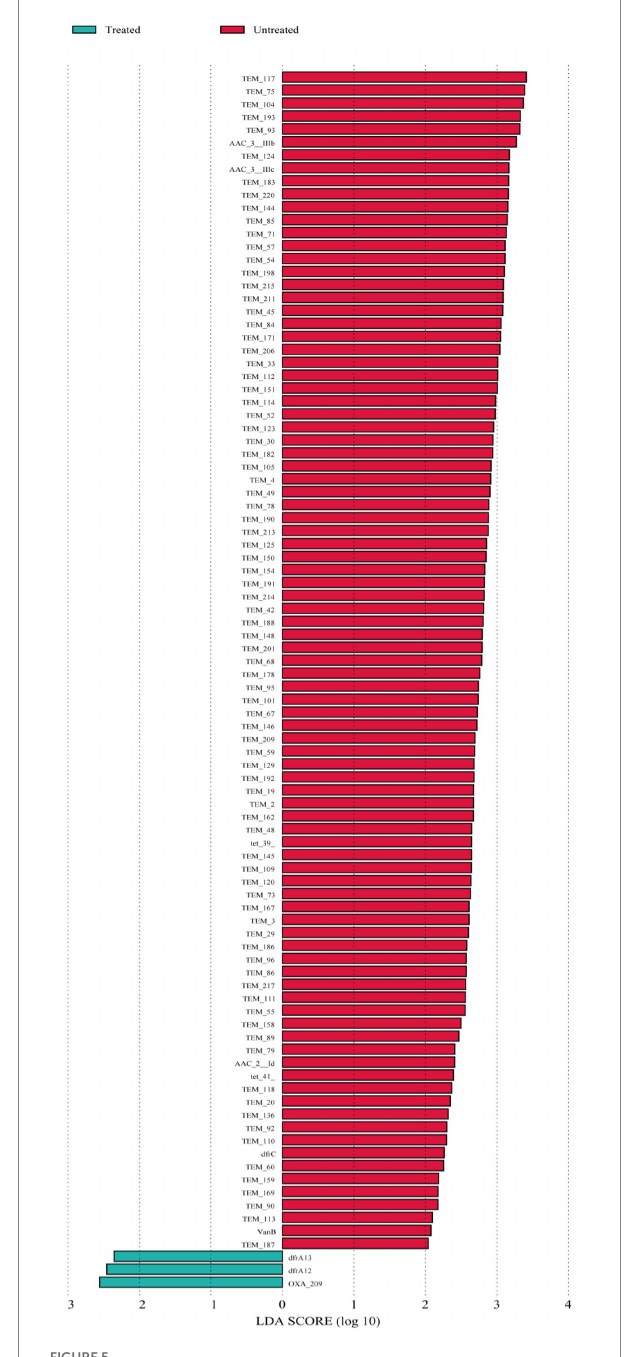
FIGURE 5 ARGs linear discriminant analyses. Each horizontal column represents an ARG, and the length of the column corresponds to the LDA value. The larger the LDA value, the larger the difference. The color of this bar corresponds to the grouping of feature